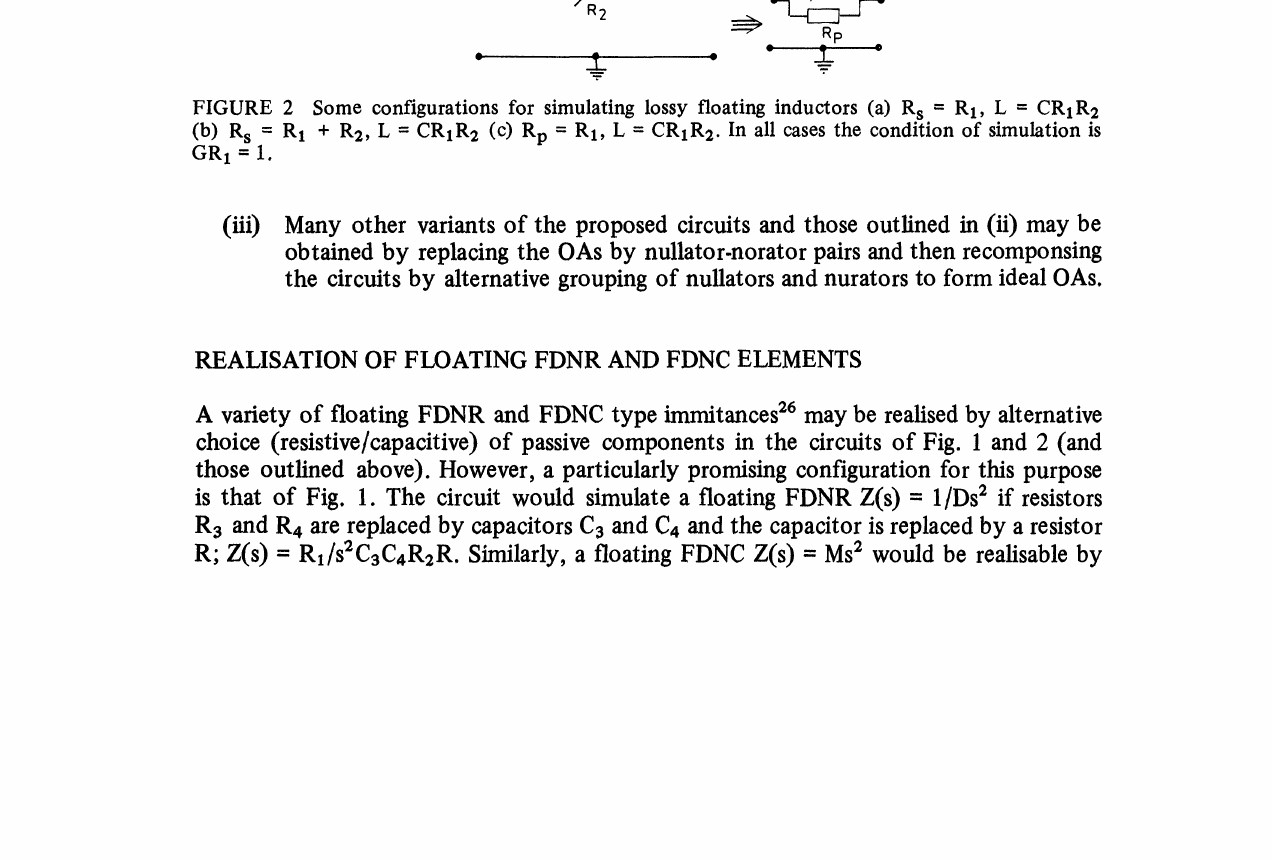
CRR2. In all cases the condition of simulation is